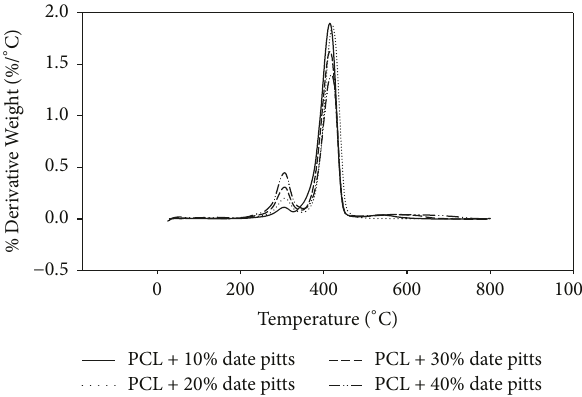
Figure 7: Derivative weight loss of PCL and date pits blends as a function of degradation temperature at 30 ∘ C heating